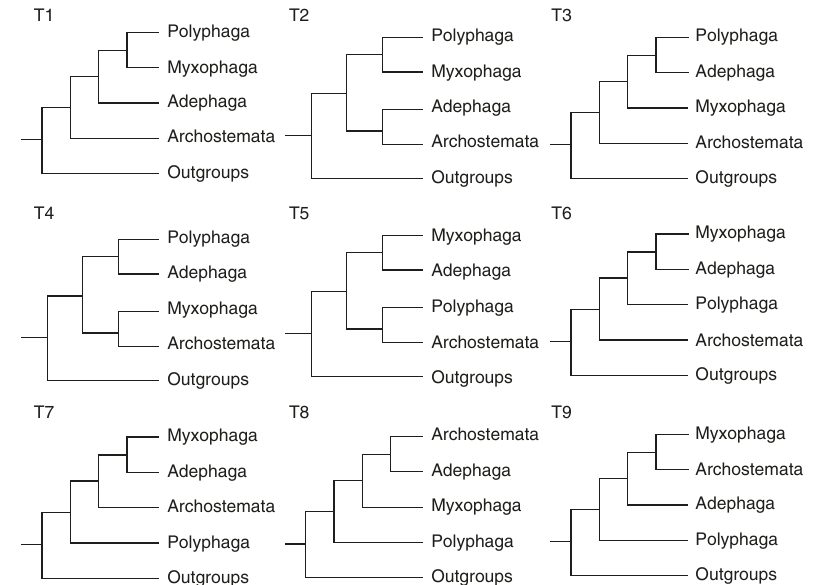
Fig. 1 Nine proposed topologies among four suborders of Coleoptera. Topologies are derived from: T1, refs. 5,19 ; T2, ref. 11 ; T3, refs. 14,20 ; T4, ref. 12 ; T5, ref. 21 ; T6, ref. 22 ; T7, ref. 18 ; T8, refs. 17,23 ; T9 refs.